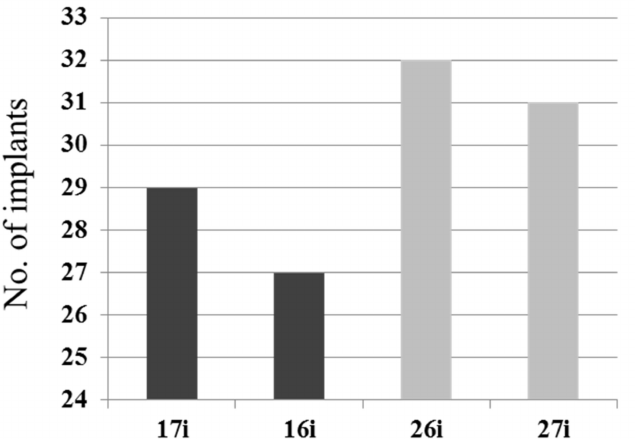
Figure 2. Distribution of molar implants. For the first and second molar replacements, 59 implants (49.6%) and 60 implants (50.4%) were placed,